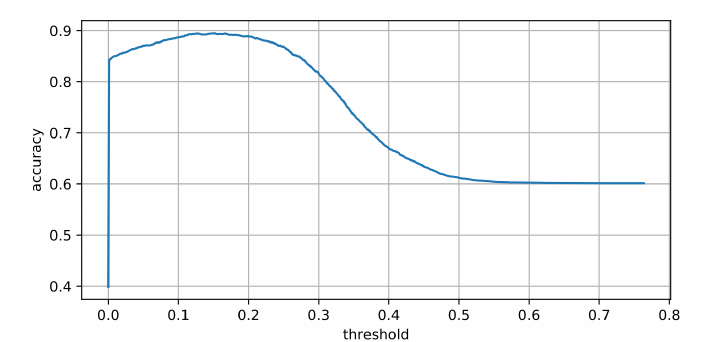
Figure 5. Moving vs. stationary: we plot the classification accuracy for a range of person assignment thresholds θ p in order to identify an optimal